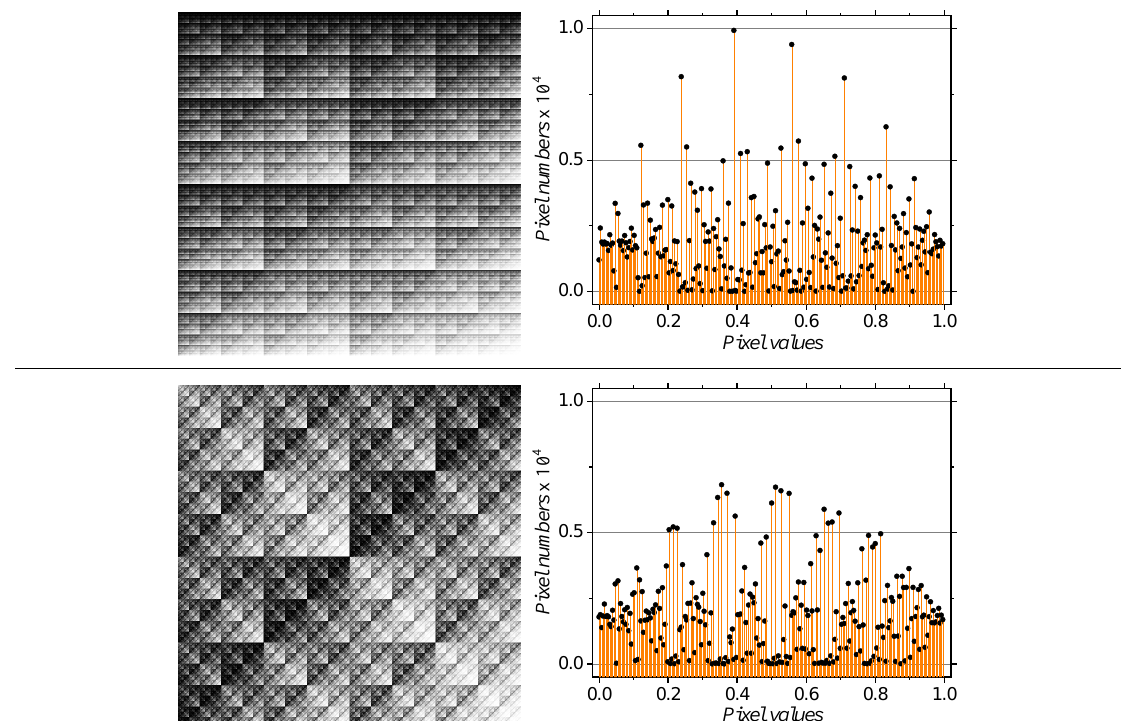
Figure 5. Images with equalized histograms for configurations M5 (upper-left corner) and M6 (low-left corner). Upper- and lower-right corers: the corresponding